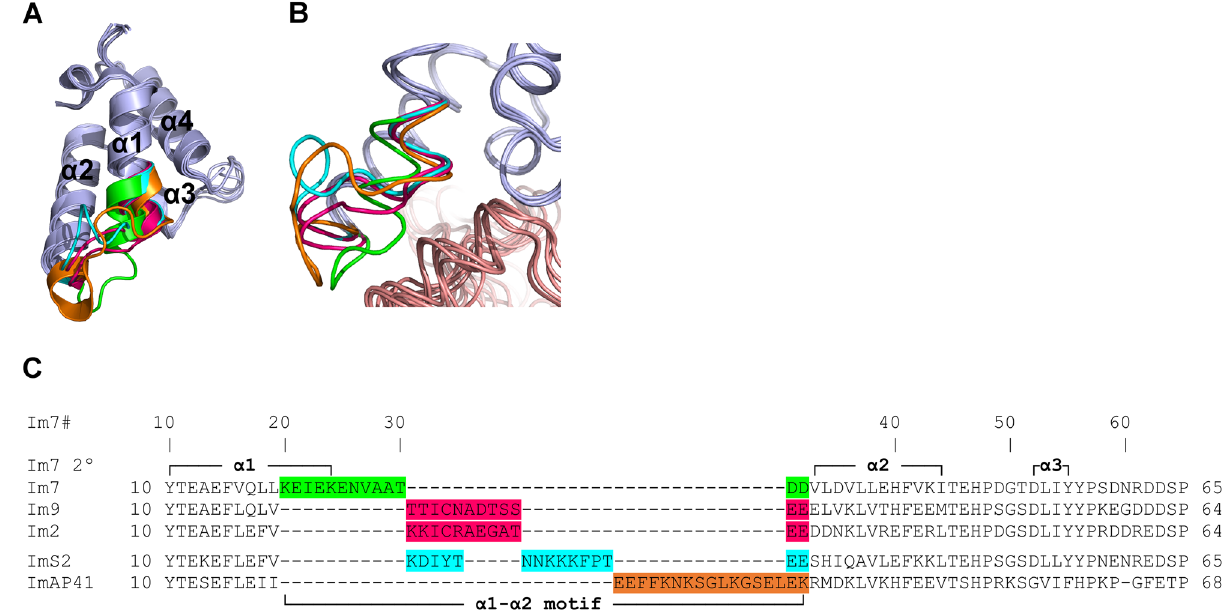
Figure 2. The α1–α2 loop and adjecent residues in immunity proteins adopt different conformations in members of the Im7-like family. ( A ) The immunity protein “α1–α2 motif”, defined as the structurally-dissimilar region with observed Cα distances of more than 1.5 Å between at least two of the structures. The representative structures from the Im7-like family (Fig. 1A) were superimposed and their α1–α2 motifs were colored as follows: Im7, green; Im9 and Im2, pink; ImS2, cyan; ImAP41, orange. ( B ) Close-up of the α1–α2 motif, rotated 45° about the Y-axis relative to ( A ). Colicins and immunity proteins are colored pink and light blue,